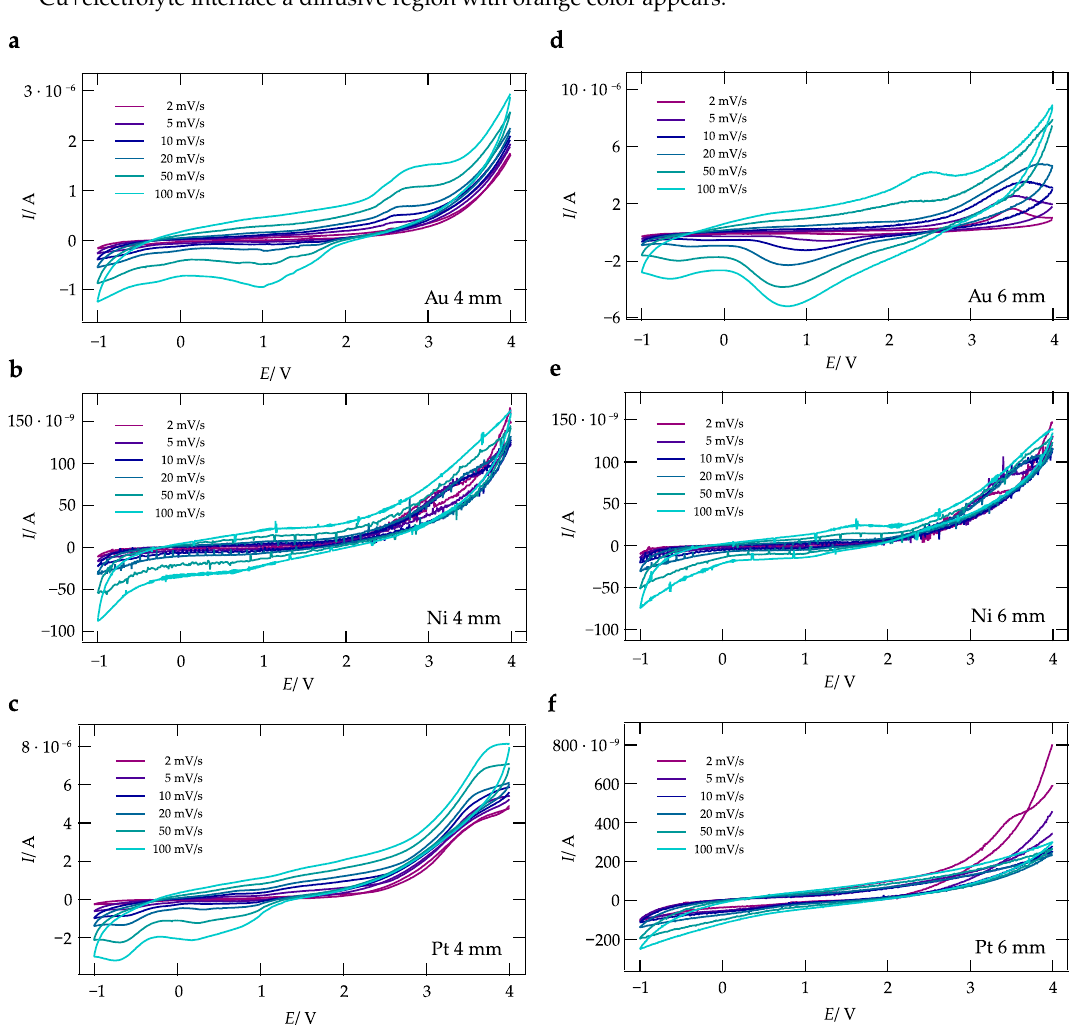
Figure A3. CVs for symmetric La 0.9 Ba 0.1 F 2.9 cells (0.002 V/s to 0.1 V/s, 200 ◦ C) with Au electrodes (WE d = 4 mm and d = 6 mm see ( a , d )), Ni electrodes (WE d = 4 mm and d = 6 mm see ( e , b )), and Pt electrodes (WE d = 4 mm and d = 6 mm see ( c , f